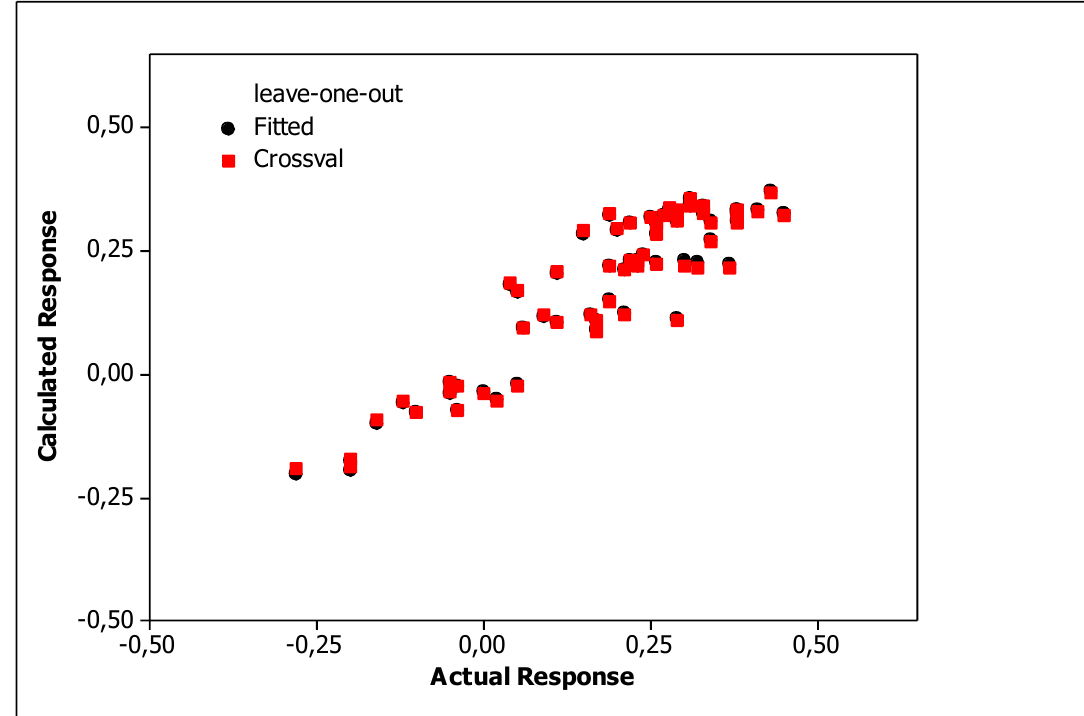
Figure 4. PLS standardized coefficient plots obtained for Equation (12) ( A ), Equation (13) ( B ) and Equation (14) ( C